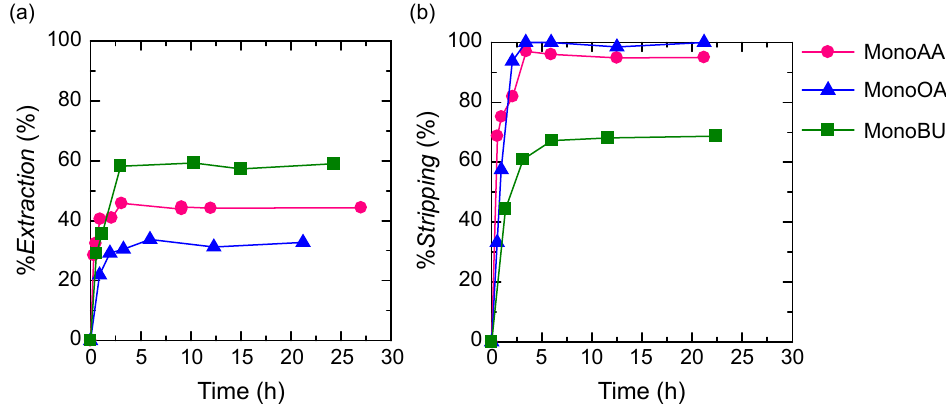
Figure 3. Effect of shaking time on the ( a ) extraction and ( b ) stripping percentages of Pt(IV) by MonoAA, MonoOA, and MonoBU. [Extractant] org,i = 1.0 M in n -dodecane/2-ethylhexanol (80 vol%/20 vol%), [Pt(IV)] aq,i = 0.243 M, [Ir(III)] aq,i = 4.92 × 10 − 3 M, [Rh(III)] aq,i = 0.117 M, [Cu(II)] aq,i = 0.291 M, [HCl] aq,i = 2.0 M.